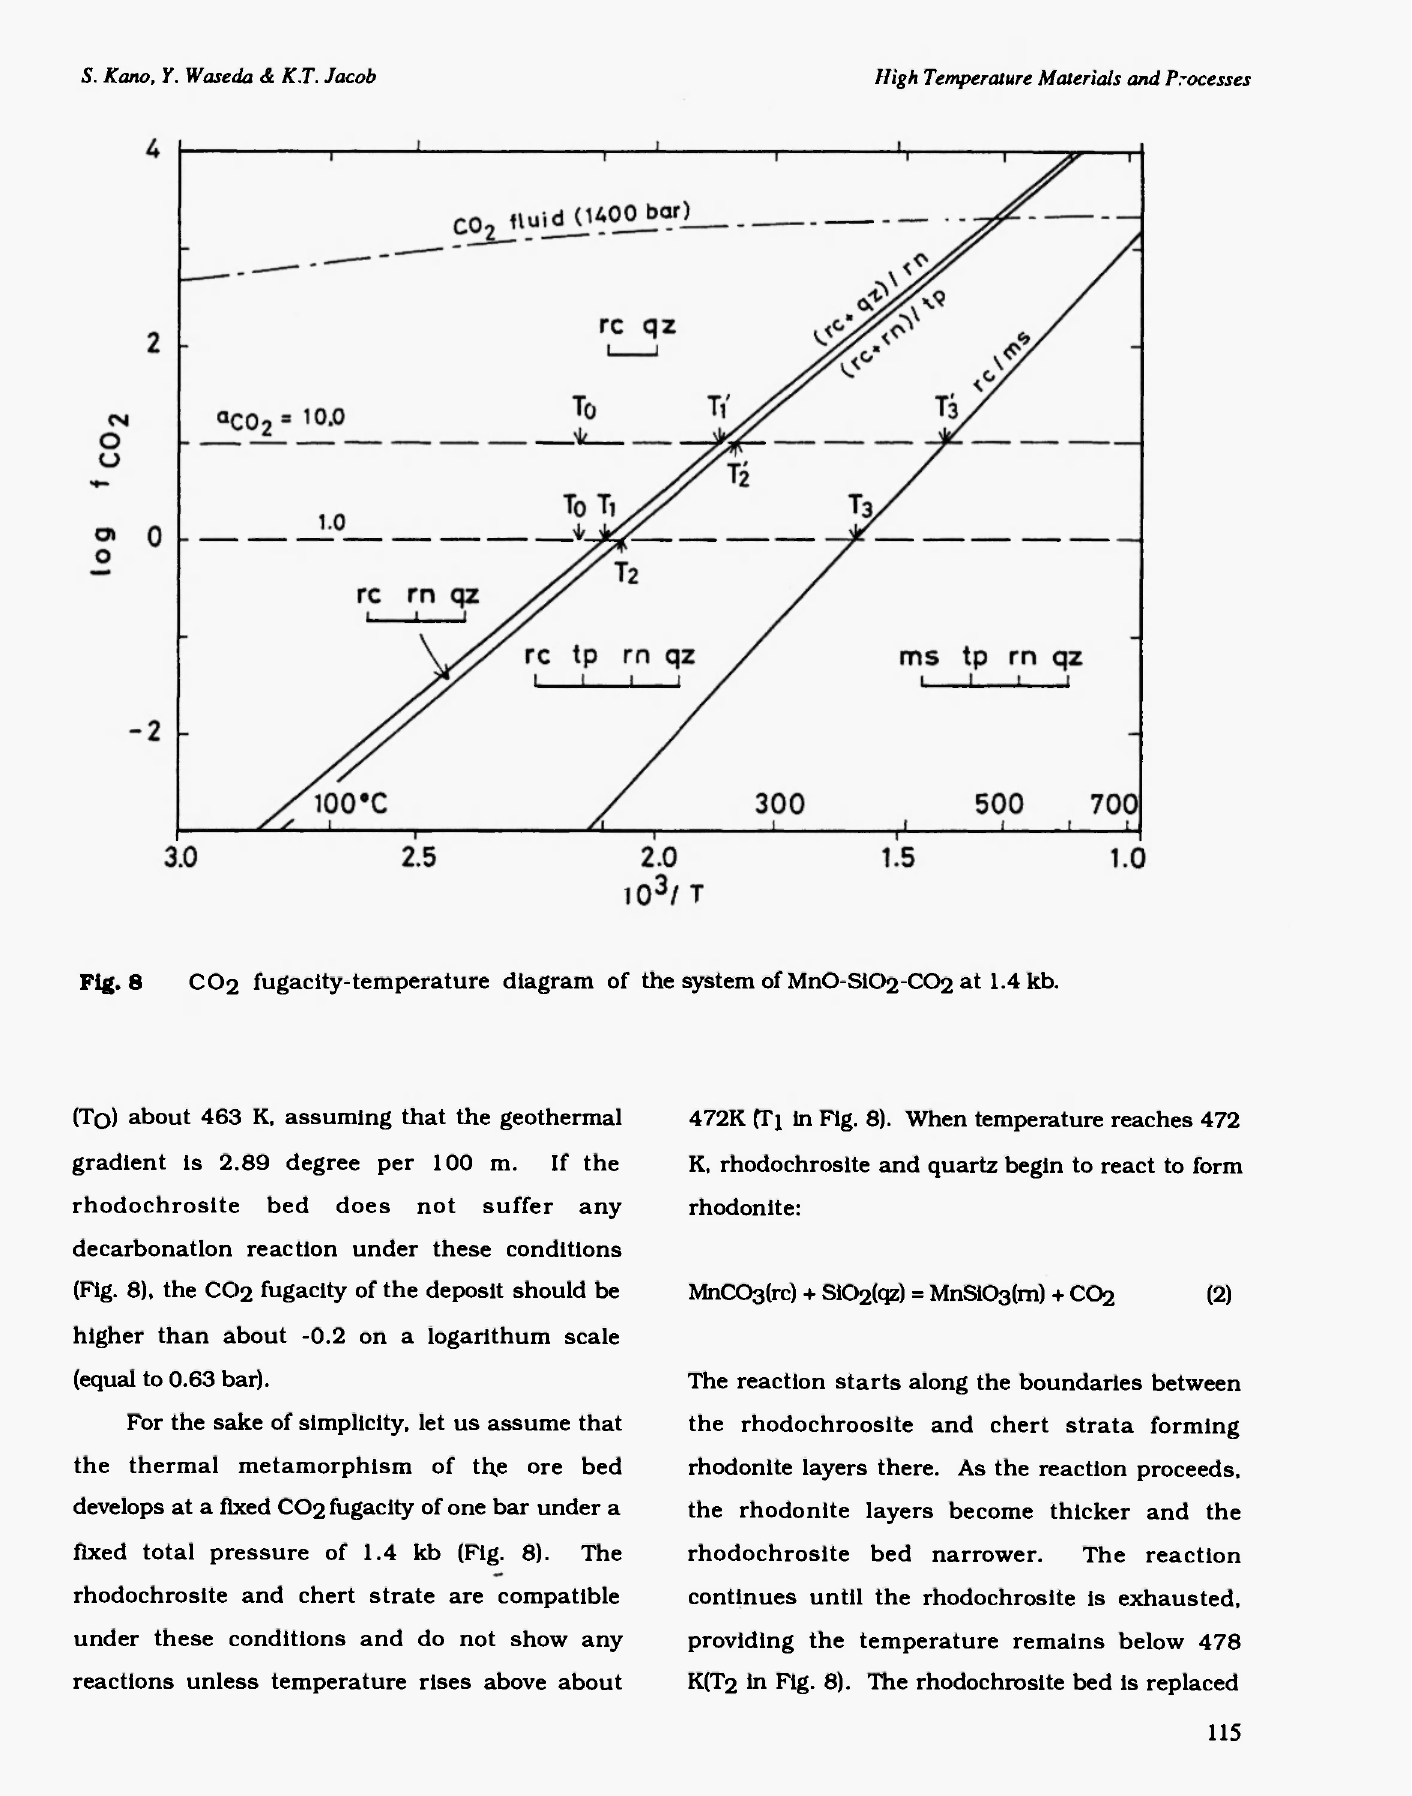
(To) about 463 K, assuming that the geothermal gradient is 2.89 degree per 100